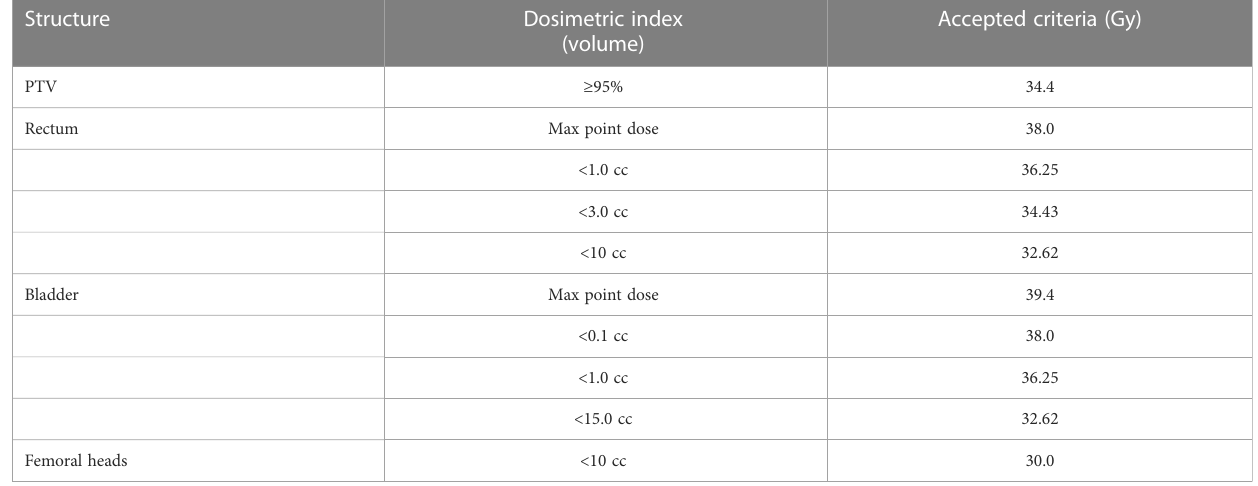
TABLE 1 Target volume and organs at-risk constrains for treatment